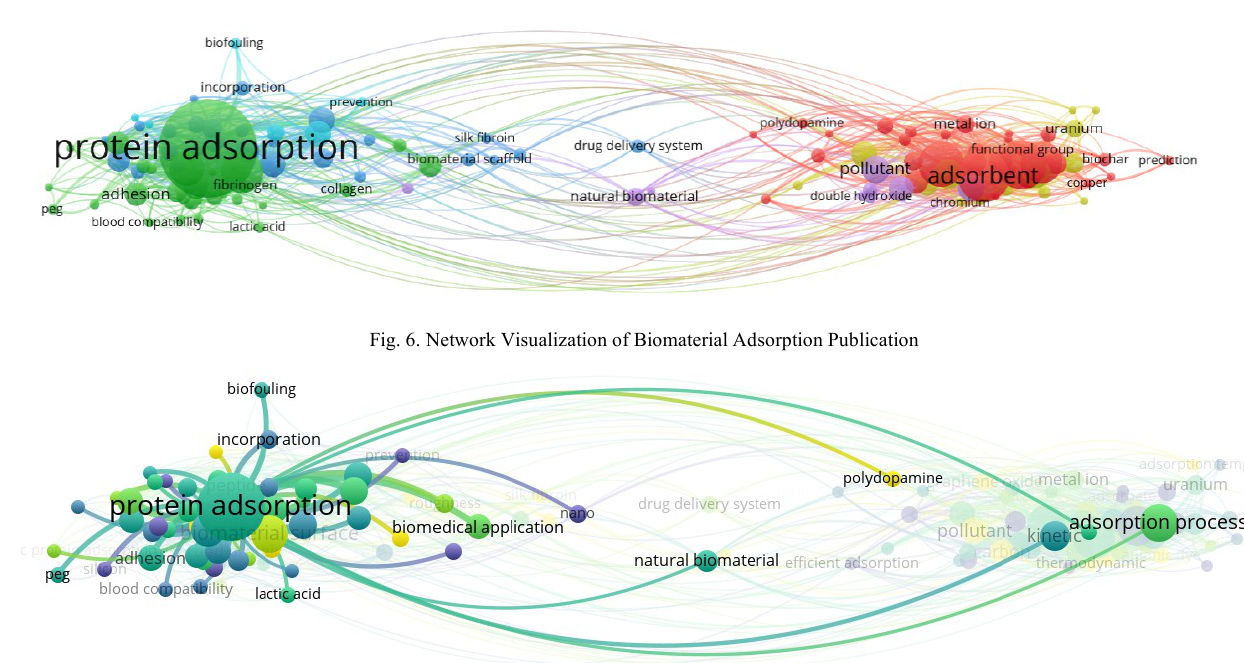
Fig. 7. Network Visualization of Protein Adsorption